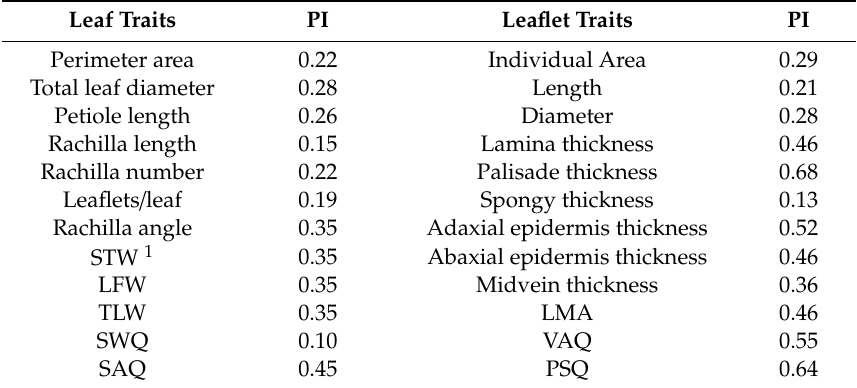
Table 4. Plasticity index (PI: maximum mean—minimum mean / maximum mean) of Serianthes nelsonii leaf and leaflet traits that were significantly influenced by percent sunlight transmission during leaf growth. Leaf Traits PI Leaflet Traits PI Perimeter area 0.22 Individual Area 0.29 Total leaf diameter 0.28 Length 0.21 Petiole length 0.26 Diameter 0.28 Rachilla length 0.15 Lamina thickness 0.46 Rachilla number 0.22 Palisade thickness 0.68 Leaflets / leaf 0.19 Spongy thickness 0.13 Rachilla angle 0.35 Adaxial epidermis thickness 0.52 STW 1 0.35 Abaxial epidermis thickness LFW 0.35 Midvein thickness 0.36 TLW 0.35 LMA SWQ 0.10 VAQ SAQ 0.45 PSQ